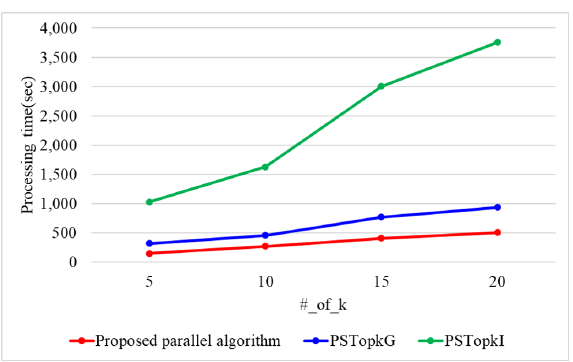
Figure 16. Processing time with a varying number of k in real dataset.